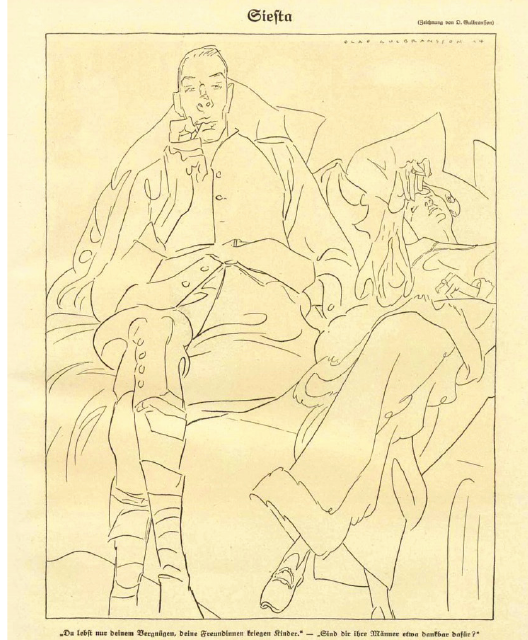
Figure 6. ‘Siesta’, Simplicissimus , 21 July 1924, p. 251. Image courtesy of Herzogin Anna Amalia Bibliothek Weimar. © DACS2014.